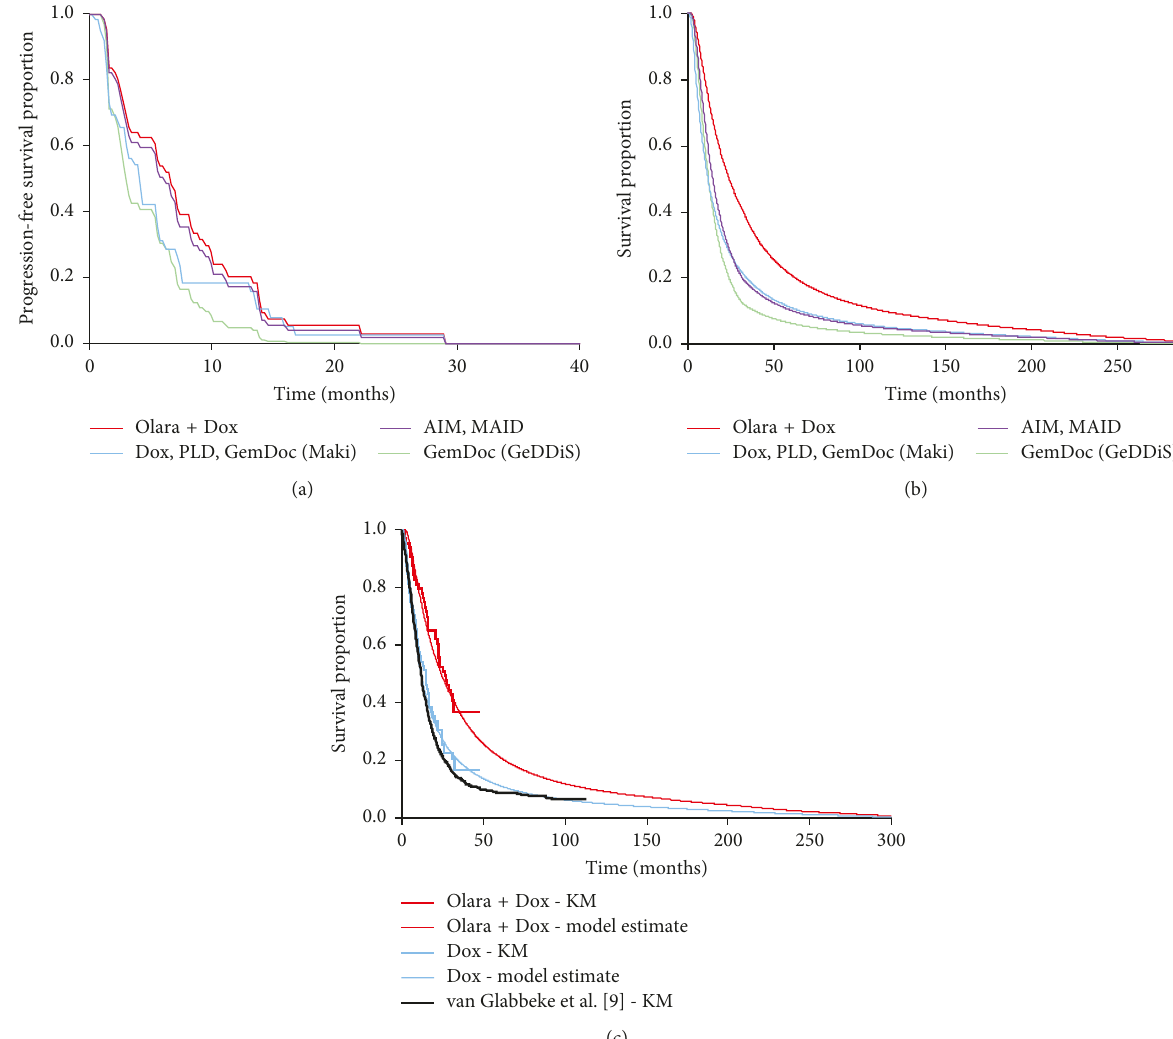
Figure 2: Survival estimates. (a) Progression-free survival; (b) overall survival; (c) overall survival validation. For the parametric survival models for PFS and OS, the following covariates were significant in most of the survival models explored and were included in the final set of survival models: tumor type and line of therapy and (where treatment was included as an indicator) the interaction of treatment with tumor type and line of therapy. For OS, the following additional covariates were significant in most models and were also included as covariates in the final analyses: sex and Eastern Cooperative Oncology Group performance status. AIM